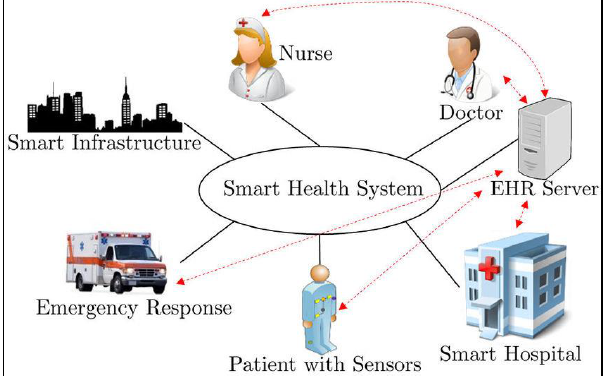
Figure 1: Smart health System